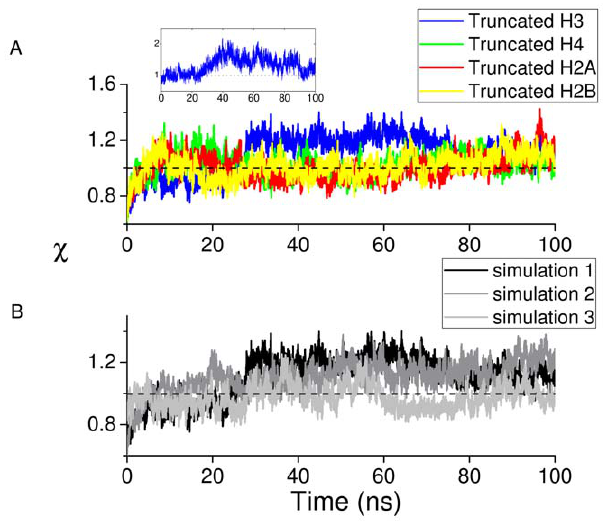
Figure 7. Destabilization of DNA upon tail truncation. (A) Order parameter x for DNA from the four tail-truncated nucleosome simulations. The inset shows the order parameter for the DNA segment between the dyad and SHL + 1.5 for the H3 tail-truncated nucleosome simulation. (B) The order parameter x for DNA from three independent H3-tail truncated nucleosome